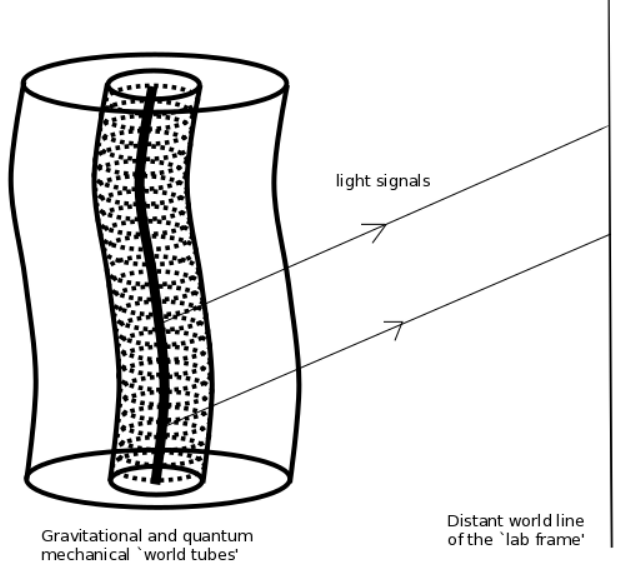
Figure 2. Measurement of the time-like interval traversed by a massive particle located at r (cid:39) 0, by projecting light-like signals emitted over the course of its path onto a “detector” at r > 0. The outer tube surrounding the centre of mass (CoM) represents the region r < r grav , in which the particle’s gravitational field may be considered non-negligible compared to the background curvature. Placing the detector within r grav leads to significant differences between the measured (lab frame) and “true” (CoM frame) values, even in the classical regime (Equation (23)). The inner tube represents the fuzziness of the particle’s CoM due to the minimum width of the canonical quantum wave packet, i.e., the Compton radius. Generally, the tubes defined by the gravitational and quantum mechanical radii have different thicknesses, but coincide for the minimum-mass particle predicted by the DE-UP (see Section